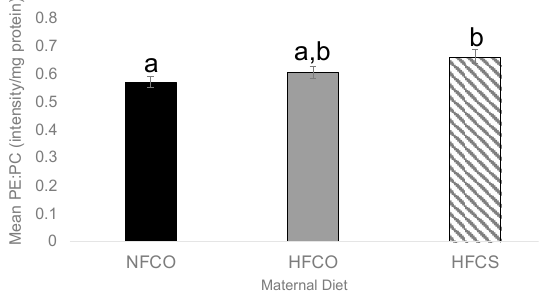
Figure 3. Fetal liver PE-to-PC ratios. Values represent means ± SEM. a,b, different letters indicate significant differences between groups ( p < 0.05) analyzed with ANOVA and Post-hoc Fisher’s LSD; any two groups with no overlapping letters were significantly different in their pair-wise comparison; CO, untreated control without choline supplement; CS, choline-supplemented; HF, high-fat; NF, normal-fat; PC, phosphatidylcholine; PE, phosphatidylethanolamine.